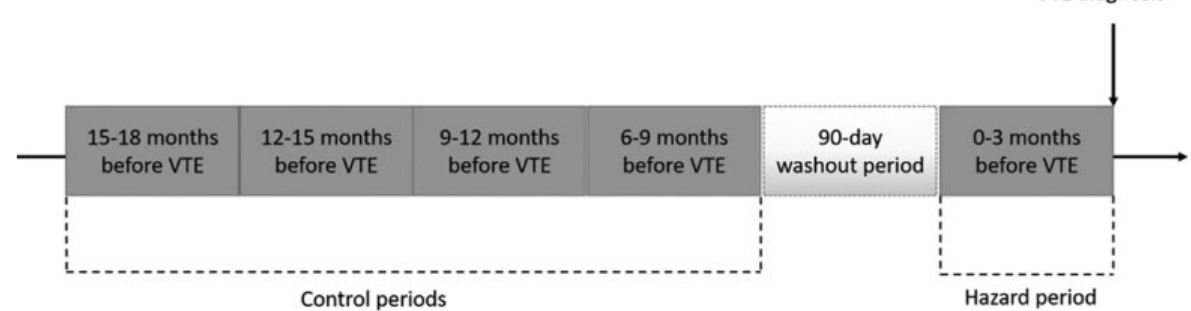
Fig. 1 Case-crossover study design. A transient risk factor, or trigger, was recorded for each case of venous thromboembolism (VTE) in the 90- day hazard period prior to the event, and in four preceding 90-day control periods, separated by a 90-day washout